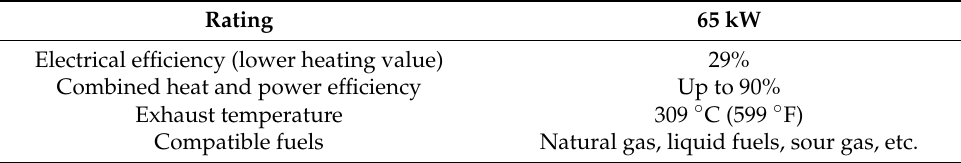
Table A1. Parameters associated with C65 MTs